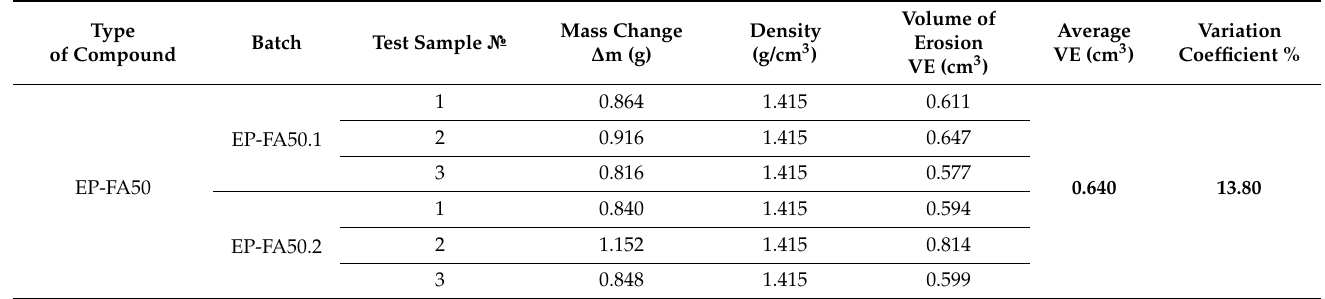
Table A17. Wear of filled epoxy binder (EP-FA50) at 180 ◦ C at an impingement angle of 90 ◦ .